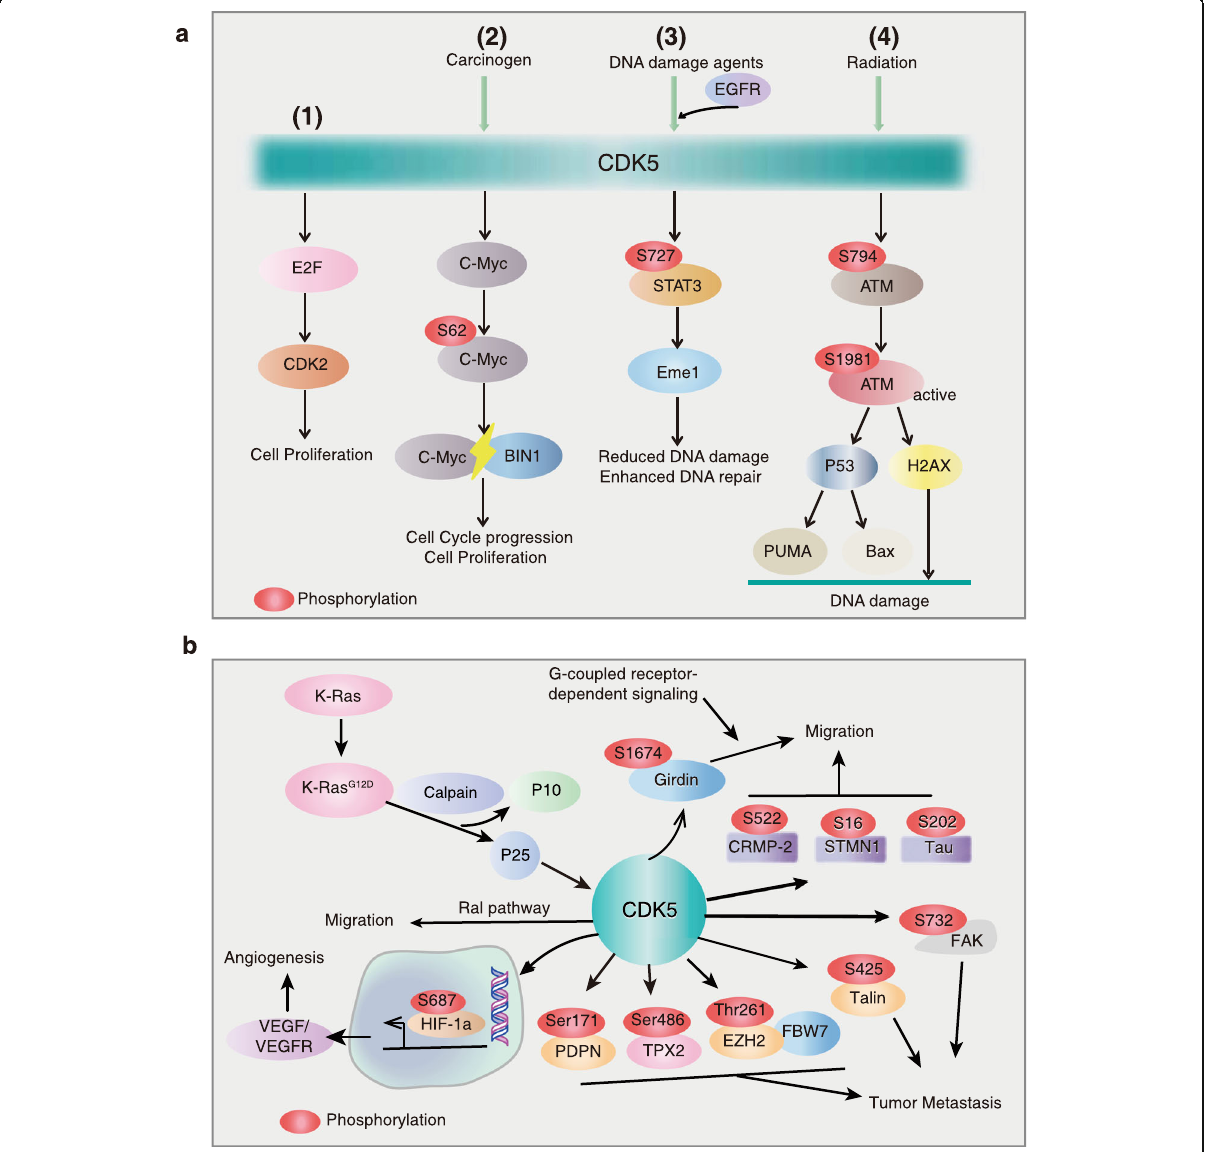
Fig. 3 PTM events in CDK5-mediated biological function in cancer progression. a PTM events in CDK5-mediated cell proliferation and DNA damage repair. (1) In cancer cells, CDK5 mediates cell proliferation through activating E2F-CDK2 pathway. (2) CDK5 induces c-Myc Ser62 phosphorylation for abolishing Bridging integrator 1 (BIN1)/c-Myc interaction, promoting cell cycle progression. (3) During DNA damage, CDK5 can be up-regulated or phosphorylated by EGFR, inducing the phosphorylation of Ser727 on STAT3, the activated STAT3 promotes the expression of Eme1 gene to initiate DNA damage repair. (4) In response to radiation, ATM can be phosphorylated by CDK5 at Ser794 and undergoes autophosphorylation at Ser1981 for activation, which signals for p53 and H2AX pathways to initiate DNA damage repair. b The mechanism of CDK5 in apoptosis, cell migration and angiogenesis. CDK5 is activated upon EGF stimulation, which regulates downstream proteins phosphorylation, including Girdin, STMN1, CRMP-2, Talin and FAK to promote cell movement and migration. K-Ras G12D promotes the production of p25 to enhance the activity of CDK5, which results in the activation of Ral (Ras-Like) pathway and morphological changes conducive to cell migration. In addition, CDK5 regulates angiogenesis through directly controlling the HIF1 α target gene, VEGF and its receptor